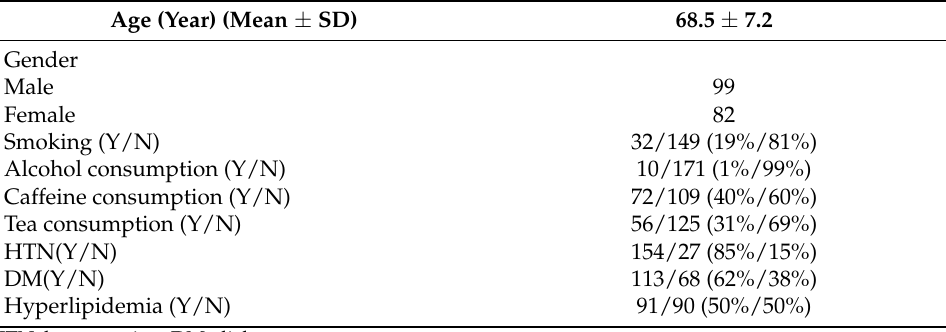
Figure 1. A 62 y/o male patient complained about chest pain and asked for help atthe CV OPD. He suffered from dyslipidemia, a risk factor for cardiovascular disease. He was referred for Dynamic SPECT/CT examination. Semi-quantitative MPI had no abnormal perfusion defect seen on ( A ). Quantitative coronary flow data of Dynamic SPECT/CT and CFC is shown on ( B ). CFC revealed moderate abnormal perfusion in RCA territory. Ischemic extent of LV was measured 8.3 (blue color), moderate abnormal perfusion of LV was measured as 28.4% (green color), and mild abnormal perfusion of LV was measured as 56% (yellow color). One month later, cardiac catheterization was arranged for him. Results of PCI were noted LCX-M 55% stenosis and RCA-orifice 70% stenosis. Due to this, the patient underwent PCI with stents over RCA territory. After PCI intervention, patient’s symptoms were improved and dyslipidemia was controlled with medication. Table 1. Characteristics of the 181 enrolled patients in this study.